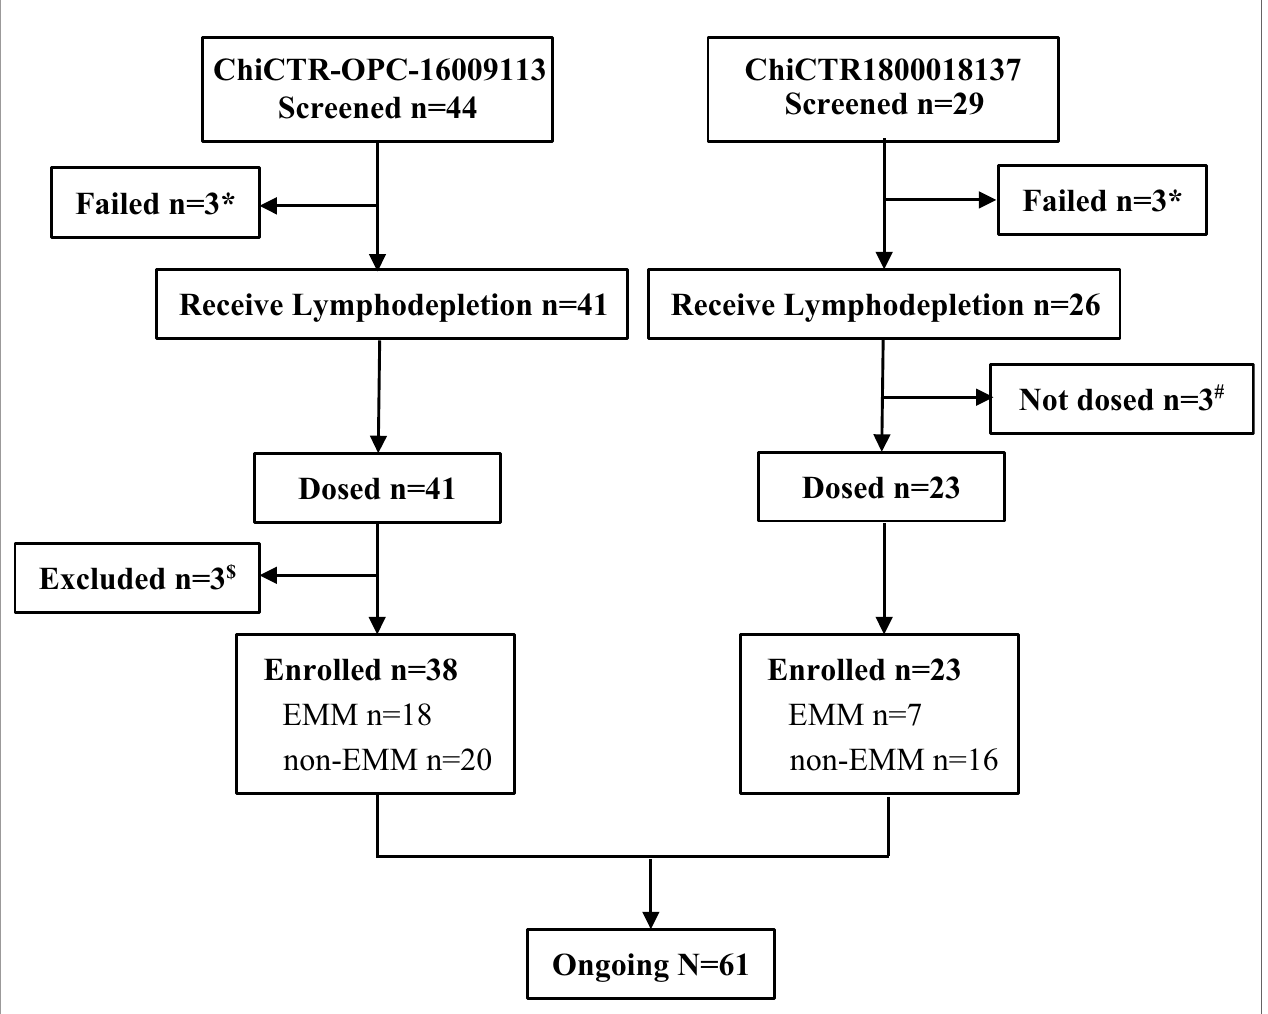
FIGURE 1 | Flowchart. *Three patients failed in the screening of trail ChiCTR-OPC-16009113, and three patients failed in screening ChiCTR1800018137, respectively, because of not meet inclusion criteria or rapid progression. # Three patients who received lymphodepletion were not dosed because of heart failure, severe liver function damage, and severe infection, respectively. $ A patient who had POEMS rather than MM or EMM was excluded, and two patients were excluded because of early